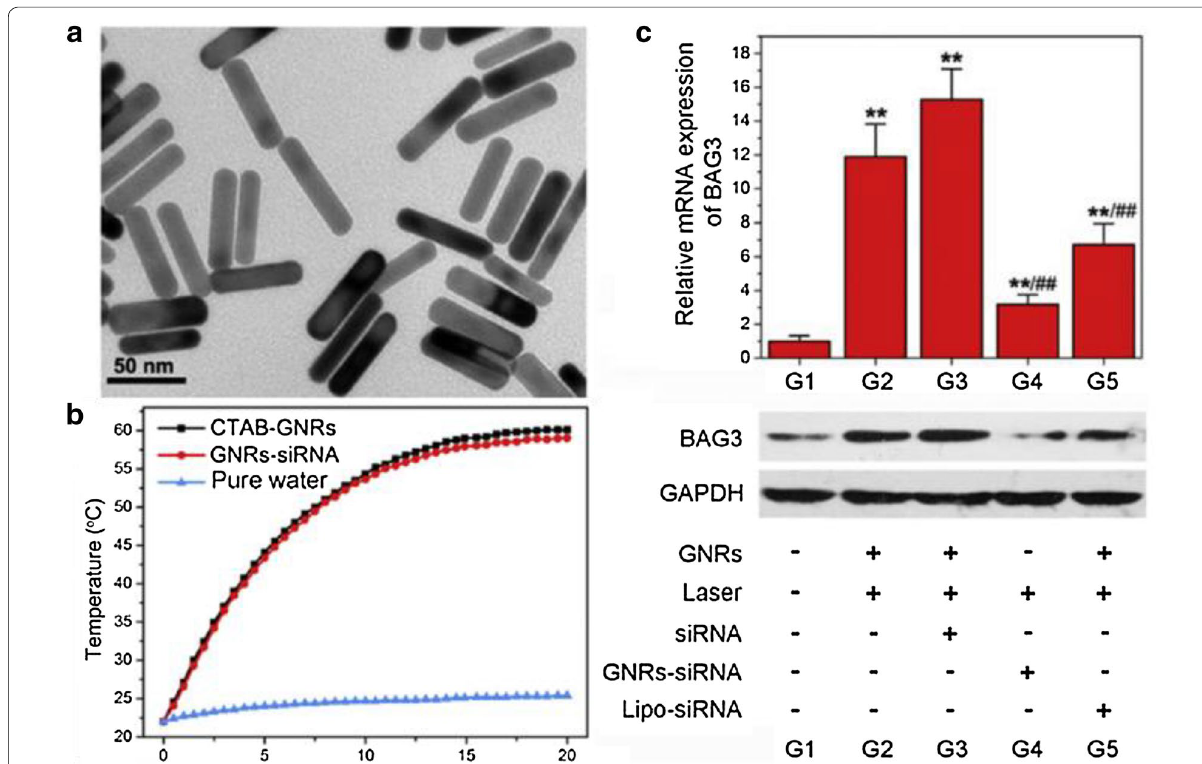
Fig. 3 a TEM image of GNRs-siRNAs as synthesized and b temperature changes after laser irradiation. c Changes in the expression level of mRNA encoding BAG3 induced by gold nanorods (Reproduced with permission [39])